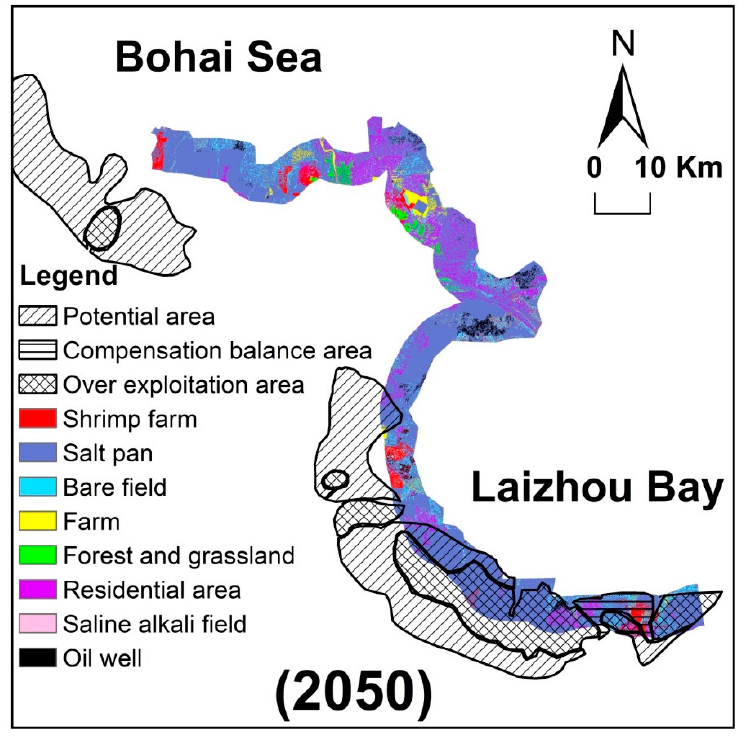
Figure 8. Distribution map of brine exploitation potential (see Section 3.4) and land-use distribution map in 2050 based on the LCM model.